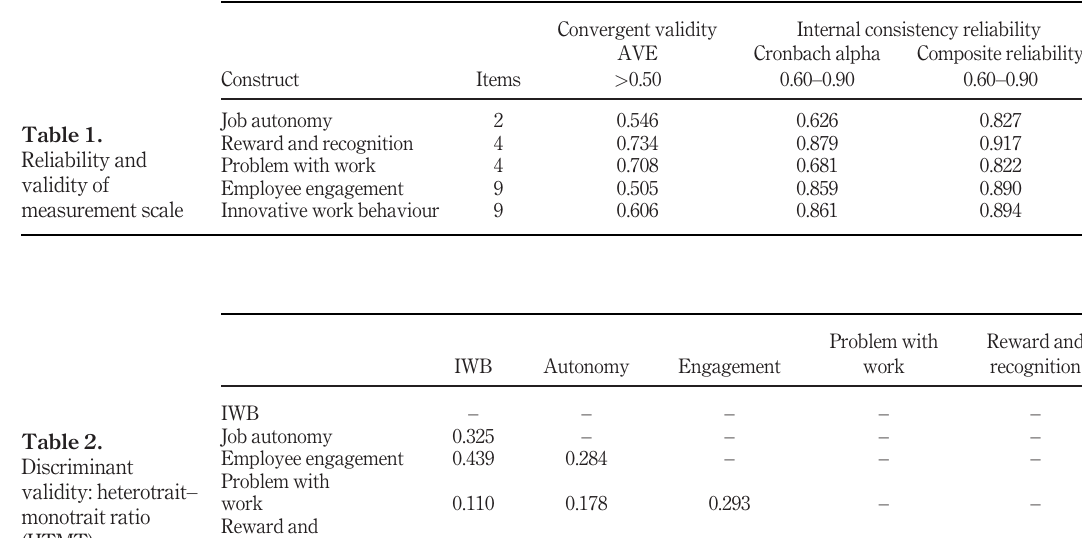
Table 2. Discriminant